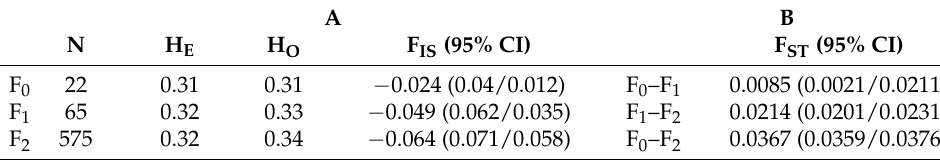
Table 1. (A) Overview of population statistics. These include the number of individuals in the popu- lation (N), the expected heterozygosity (H E ), the observed heterozygosity (H O ) and the inbreeding coefficient (F IS ) and the 95% confidence intervals (in brackets, with upper and lower confidence intervals being separated by a slash). (B) Overview of the average F ST between pairs of populations (and the 95% confidence intervals in brackets, with upper and lower confidence intervals being separated by a slash). F ST values in bold are significant. A B N H E H O F IS (95% CI) F ST (95%